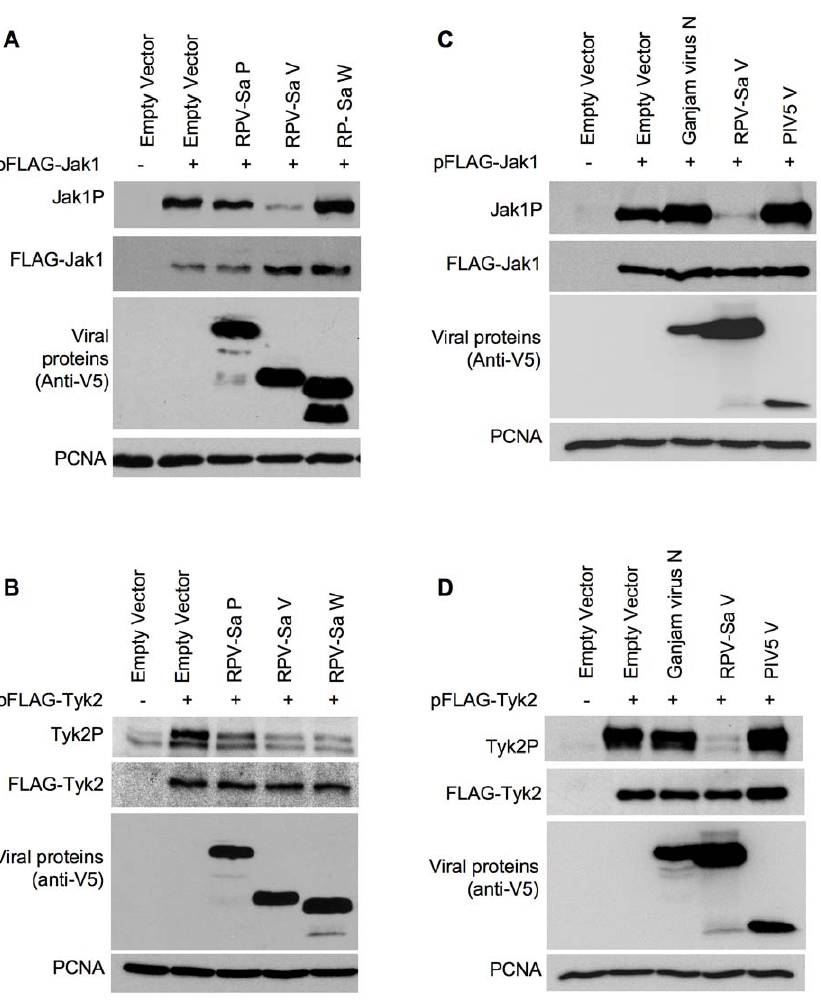
Figure 8. RPV-Sa V but not RPV-Sa P or W, nor the PIV5 V, blocks Jak1 and Tyk2 phosphorylation. (a), (c) Vero human-SLAM cells were co-transfected with pFLAGJak1 and plasmids encoding the indicated viral proteins, and Jak1 phosphorylation determined, as described for Fig. 8 (a). (b), (d) Vero dog-SLAM cells were co-transfected with pFLAGTyk2 and plasmids encoding the indicated viral proteins, and Tyk2 phosphorylation determined, as described for Fig. 8